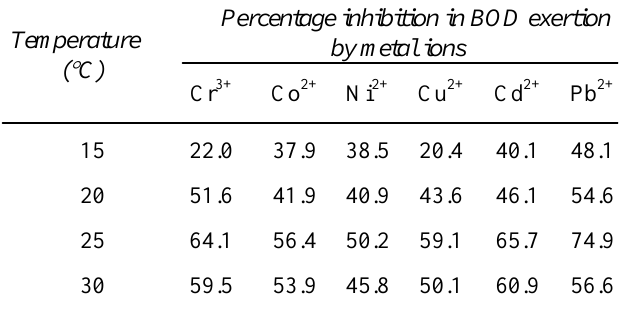
Table 1: BOD Inhibition as a function of temperature in presence of different metal ions Percentage inhibition in BOD